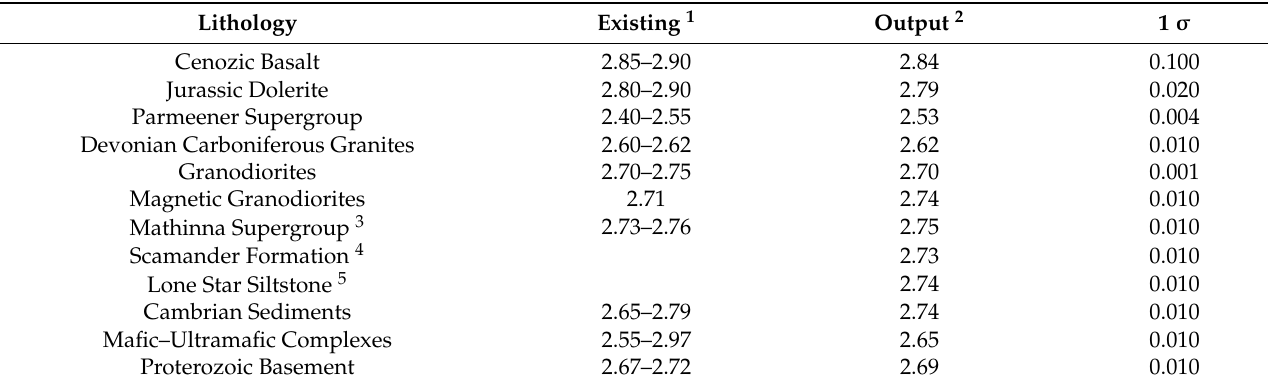
Table 3. Eastern Terrane existing and model-informed mean density (kg/m 3